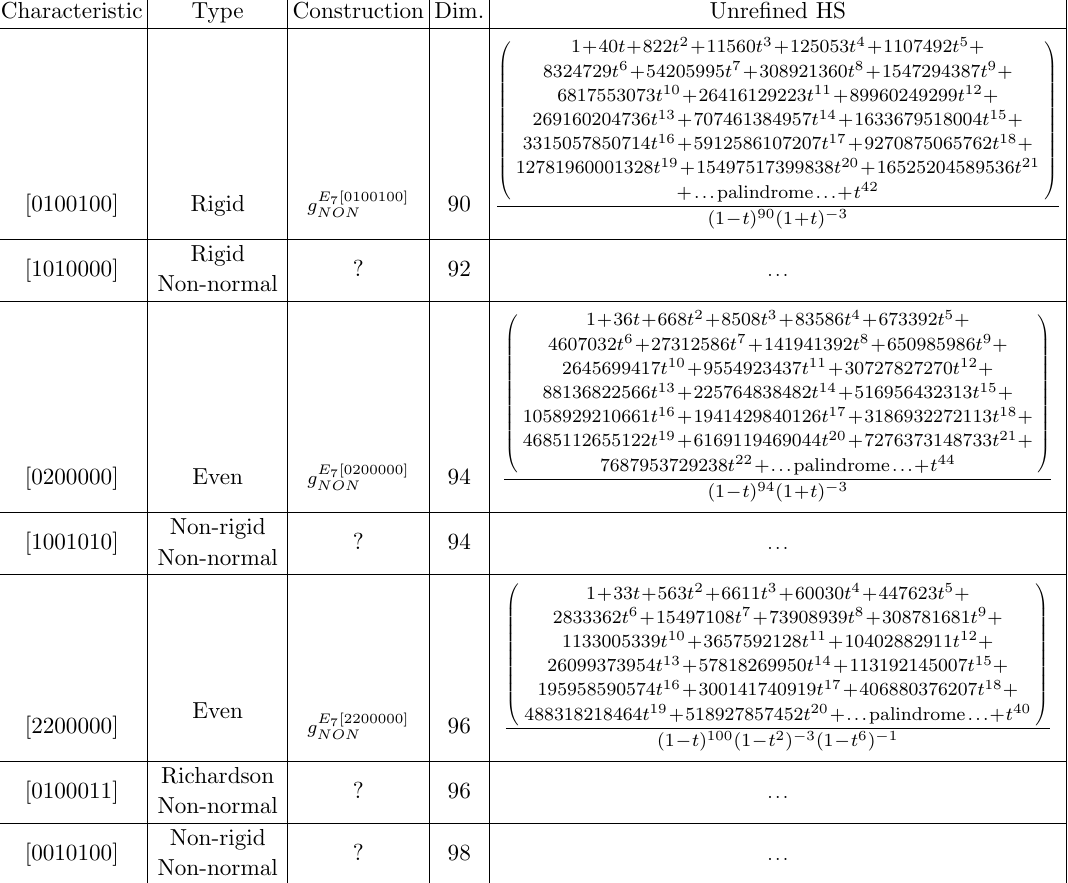
Table 20 . E 7 orbit constructions and Hilbert series